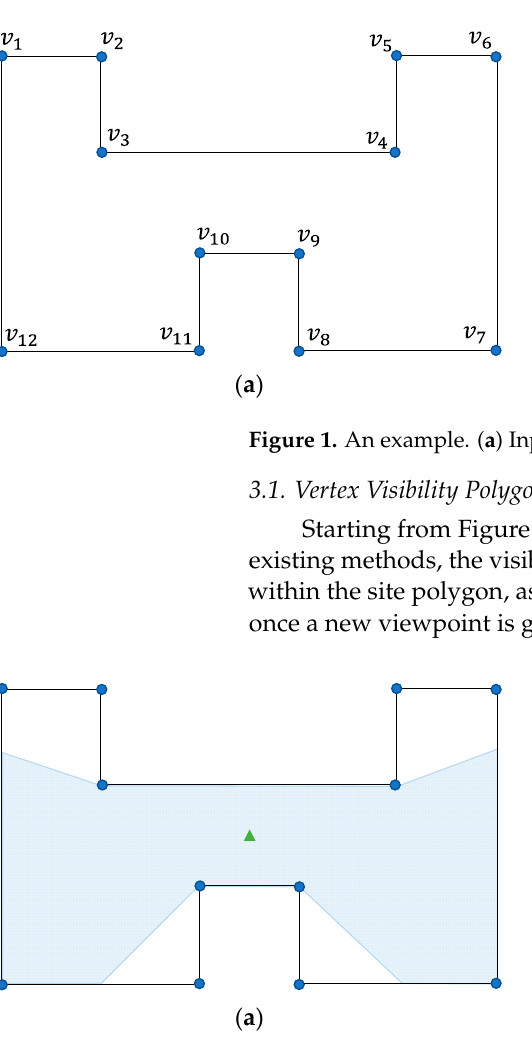
Figure 2. Visibility polygons. ( a ) For an arbitrary viewpoint; ( b ) for a polygon vertex.